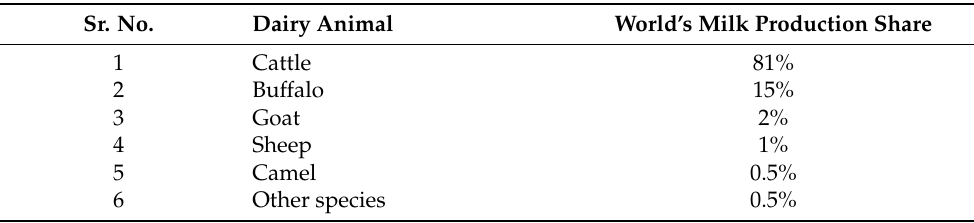
Table 1. World’s milk production share of dairy animals (Source: https://www.fao.org/dairy- production-products/en/, accessed on 5 March